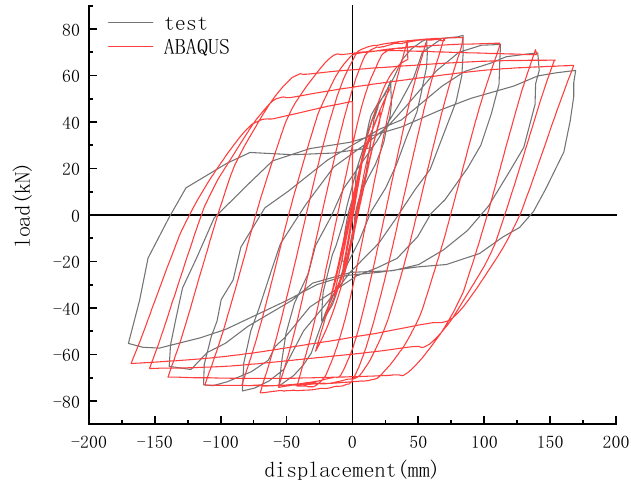
Figure 6. Hysteresis curve of LJ-1 specimens.